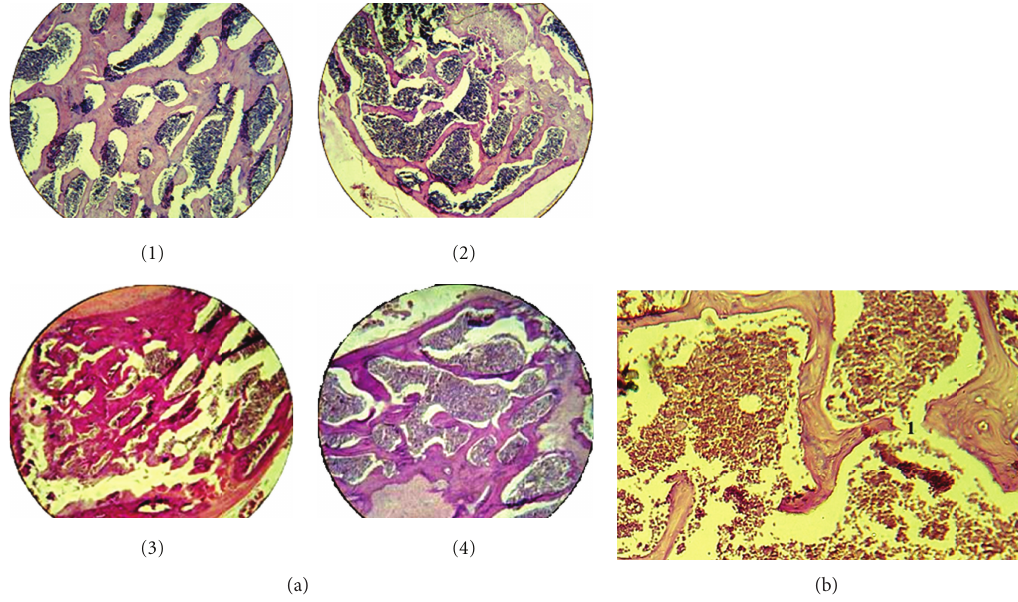
F 2: (a) e morphological picture of proximal metaphysis of femoral bone (strained with hematoxylin and eosin, SW-100). (1) In intact rats; (2) in the rat aer ovariectomy; (3) in the rat aer ovariectomy treated with enalapril; (4) in the rat aer ovariectomy treated with losartan. (b) e morphological picture of proximal metaphysis of femoral bone in rats with generalized osteoporosis (strained with hematoxylin and eosin, SW-400). Microfracture of bone